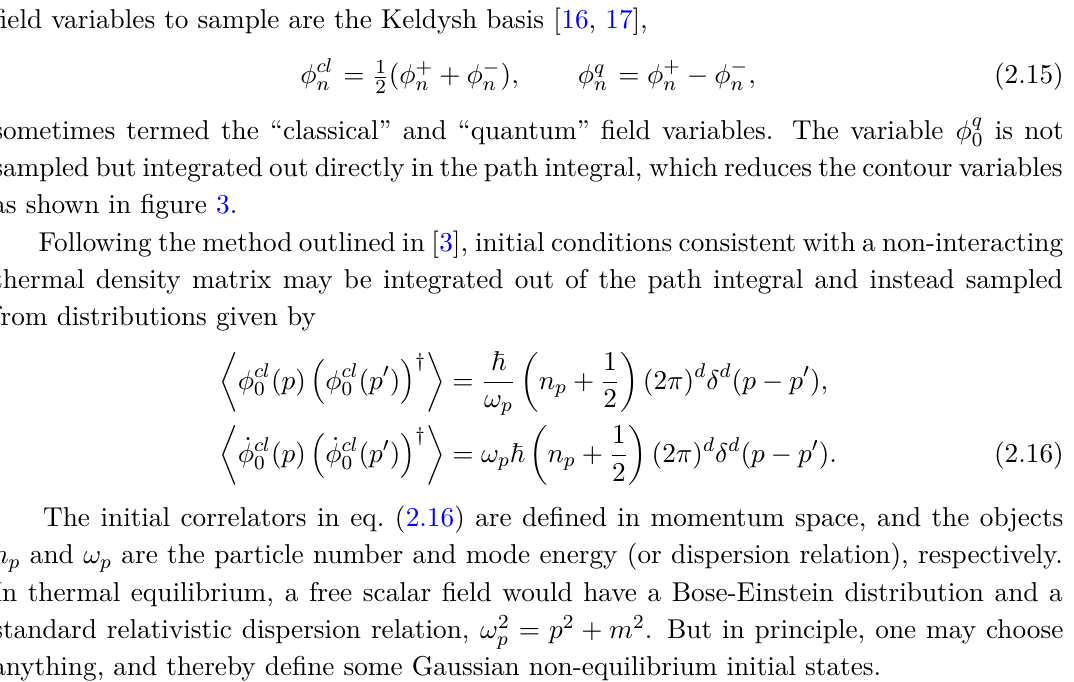
Figure 3. Reduced contour by integrating out the initial conditions. ˜ φ cl to the equation of motion for φ cl for a given set of initial